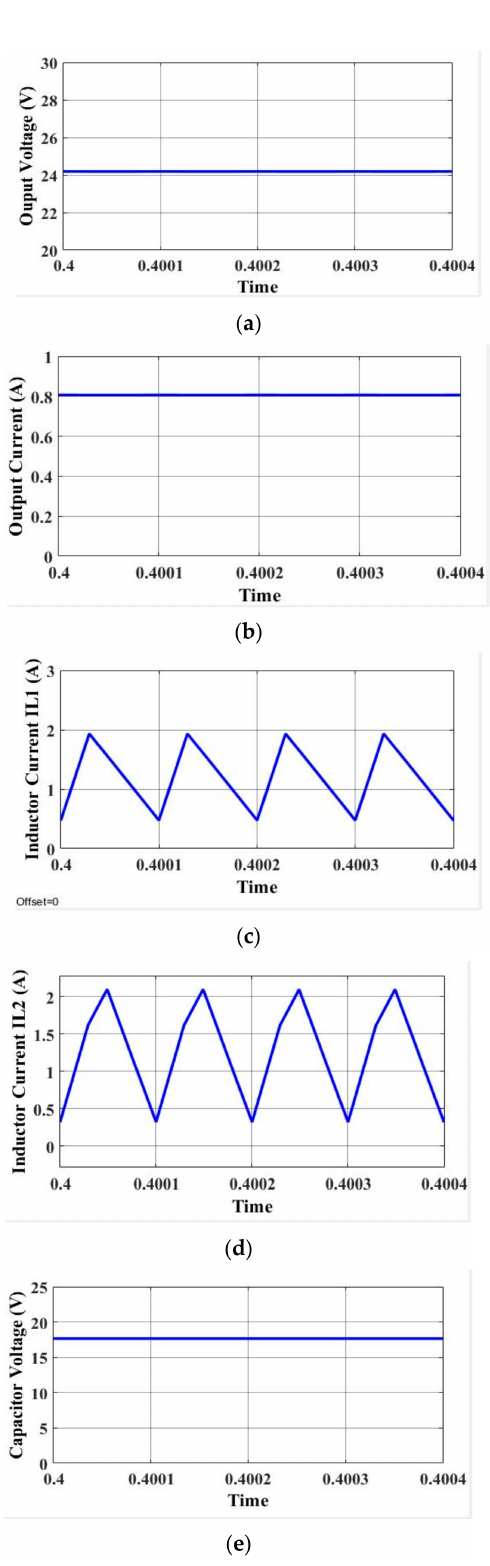
Figure 7. Output wave forms of step-down mode. ( a ) Output voltage, ( b ) output current, ( c ) inductor current (I L1 ), ( d ) inductor current (I L2 ), and ( e ) capacitor voltage (V C1